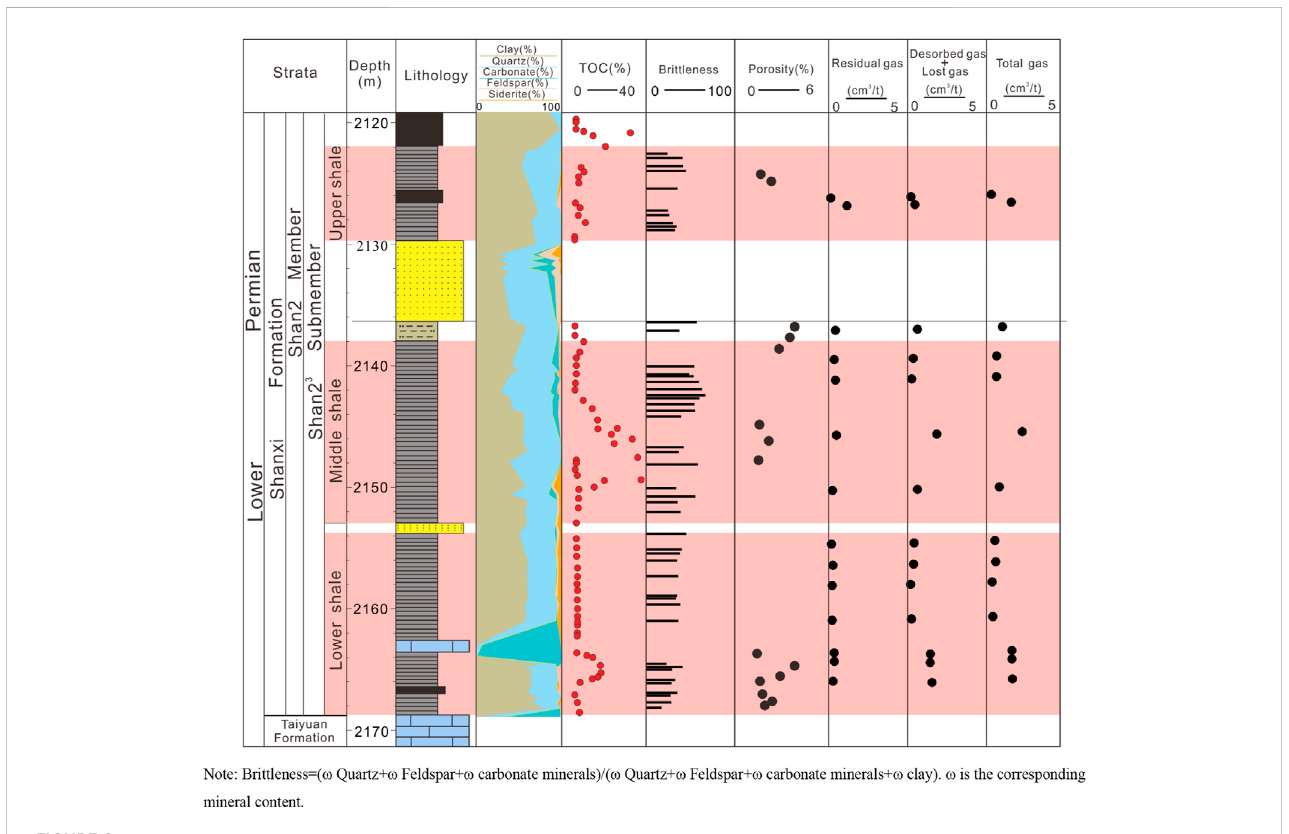
FIGURE 2 Vertical variability of TOC, mineral composition, brittleness, porosity and gas content of studied well.